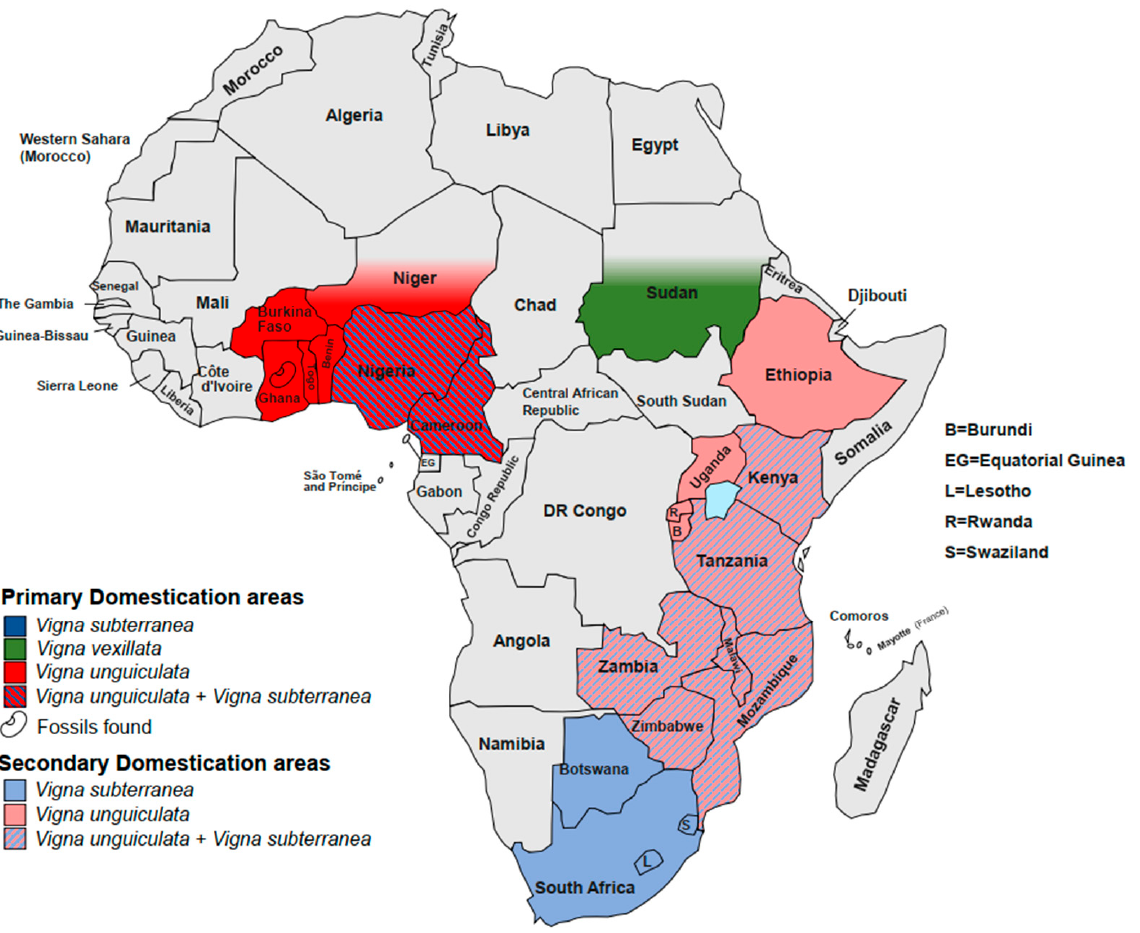
Figure 1. Primary and secondary domestication sites in Africa. Morphological and DNA markers support the idea that domestication occurred only once, but analyses on whole genomes provide evidence for more independent domestica- tion events in Africa and diversification events out of Africa [51,87]. Analyses of genetic variability are generally applied to identify the origin of species and the groups of